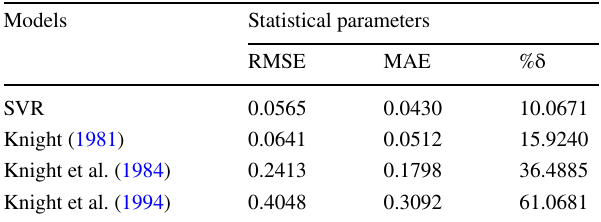
Table 5 Statistical parameters of comparison between SVR and other equations